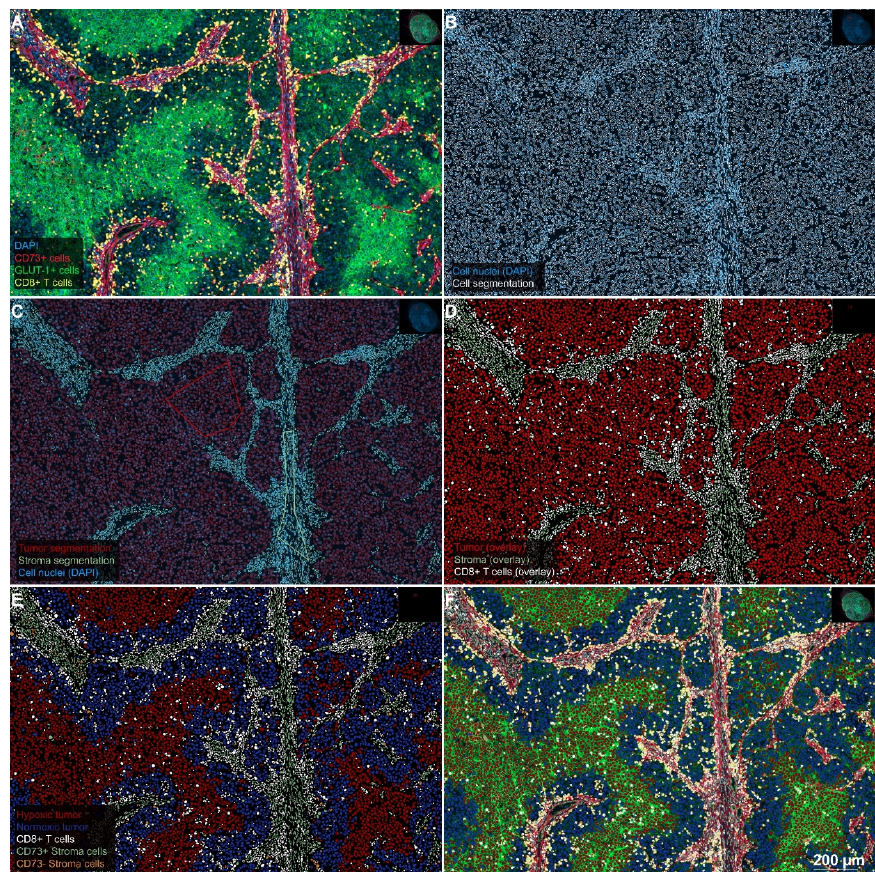
Figure 4. Stepwise procedure for the analysis of the number and spatial context of CD8-positive CTL in the hypoxic melanoma microenvironment. ( A ) Original scanned 4-plex-immunofluorescence image. A representative region of interest (5 ×) extracted from the whole-slide specimen of a patient’s lymph node metastasis demonstrates a heterogeneous staining pattern for GLUT-1 (FITC-channel, green), which reflects the diffusion-limited availability of oxygen in the melanoma microenvironment. The expression of CD73 (Alexa-647-channel, red) is largely limited to the stroma and the endothelium of tumor microvessels. CD8-positive CTL (Cy3-channel, yellow) show a strong clustering in the stroma, whereas the infiltration of CTL into GLUT-1 high tumor cell areas is sparse. Hence, the spatial distribution of CTL in this figure represents an example of an excluded infiltrate. DAPI counterstain (blue) was used for segmentation of cell nuclei. ( B ) Single-cell-based analyses were carried out using segmented nuclei (white border) as the starting point for cell detection in the open-source software QuPath. This approach enabled the systematic subclassification of all cell events. First, we subclassified cells as “tumor” or “stroma” using QuPath’s machine learning features and user-defined examples ( C ); tumor cells with a red border; stroma cells with an olive green border). Second, we further subclassified cells using intensity-thresholds in the relevant fluorescence channels in a sequential procedure, color-coding CTL with a white overlay based on the intensity in the Cy3 channel ( D ). Next, tumor cells (red overlay in D ) were further subclassified into GLUT-1 high and GLUT-1 low (i.e., presumably hypoxic and normoxic) tumor cells with a red and blue overlay, respectively ( E ), based on thresholding in the FITC-channel. Finally, stroma cells (olive green overlay in D) were subclassified into CD73-positive and CD73-negative stroma cells, based on the intensity in the Alexa 647-channel (olive green and orange overlay, respectively as shown in E ). Merging of the original 4-plex-IF-image ( A ) with the classification overlay ( E ), as shown in panel ( F ), illustrates the final result of this sequential approach. Despite a relatively dense immune infiltrate, this patient showed an overall survival of only ten